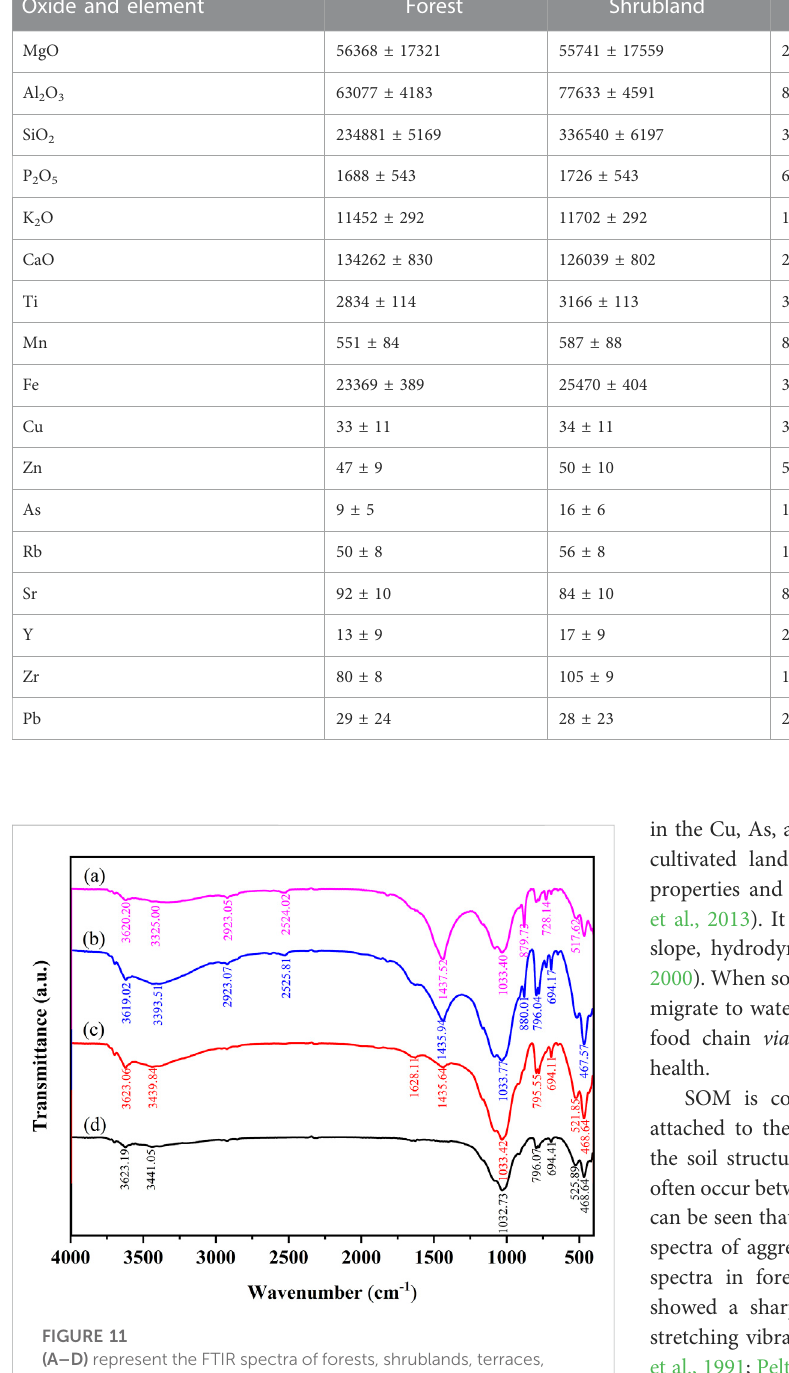
TABLE 2 Mass fraction of soil oxides and elements using XRF with standard deviation (mg · Kg -1 ). Oxide and element